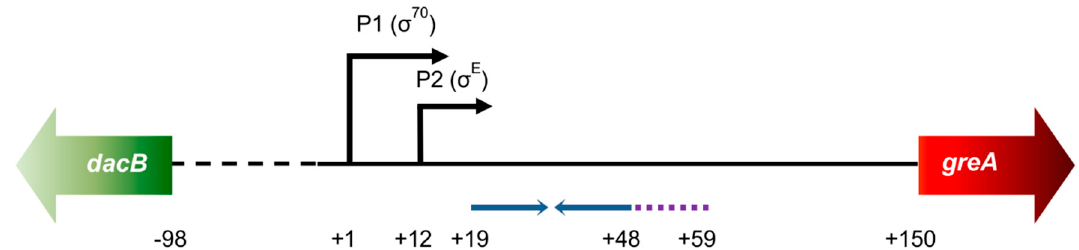
Figure 1. Schematic representation of the greA promoter and leader region. Black arrows indicate P1 ( σ 70 -dependent) and P2 ( σ E -dependent) promoters. Blue arrows indicate complementary sequences that form the GraL terminator hairpin. Purple dotted line—U-rich sequence where GraL is imprecisely terminated. The first AUG codon of greA is at position + 150; the first AUG codon of dacB is at position − 98. All numbering is in respect to the P1 transcription start site. Not drawn to scale.